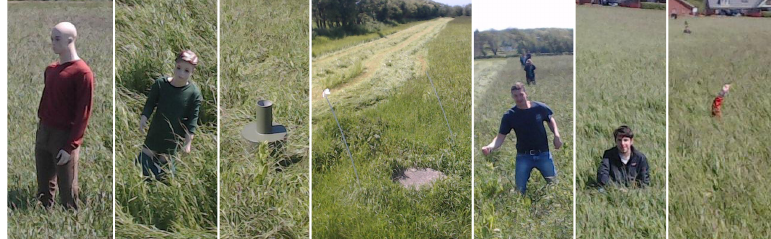
Figure 3. Two mannequins, a barrel, a well and three people, one only showing his arm, in the field.